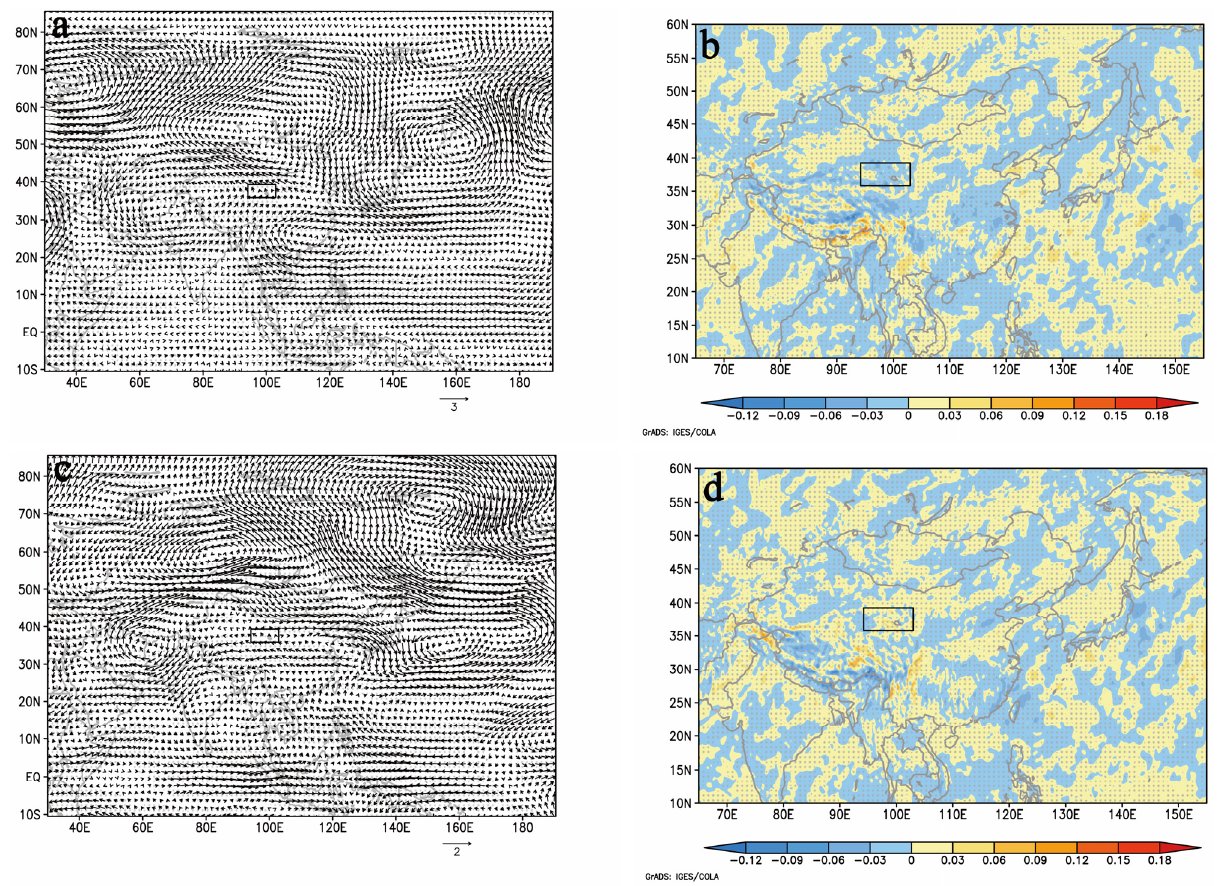
Figure 8. The 500 hPa anomalies of wind ( a , c ), and divergence ( b , d ) in the years with high and low SCFs. ( a , b ) high SCFs; ( c , d ) low SCFs.